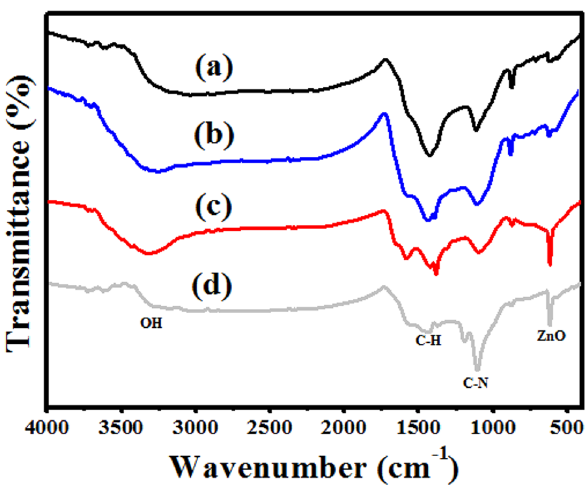
Figure 3. FT-IR spectroscopy of Biochar ( a ), Ag/biochar ( b ) ZnO/biochar ( c ), and Ag/ZnO@BC ( d ).